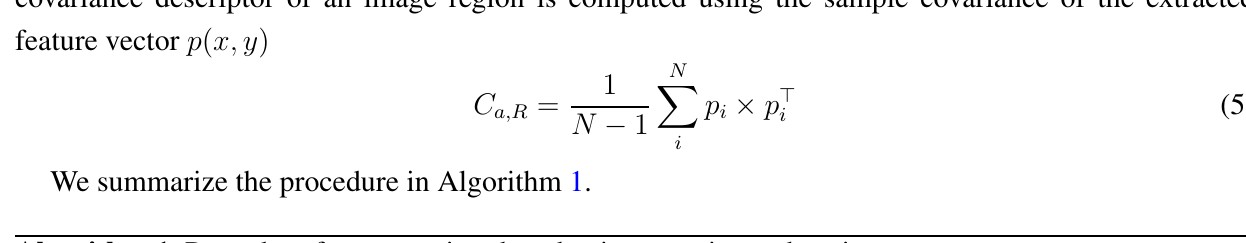
Algorithm 1 Procedure for computing the adaptive covariance